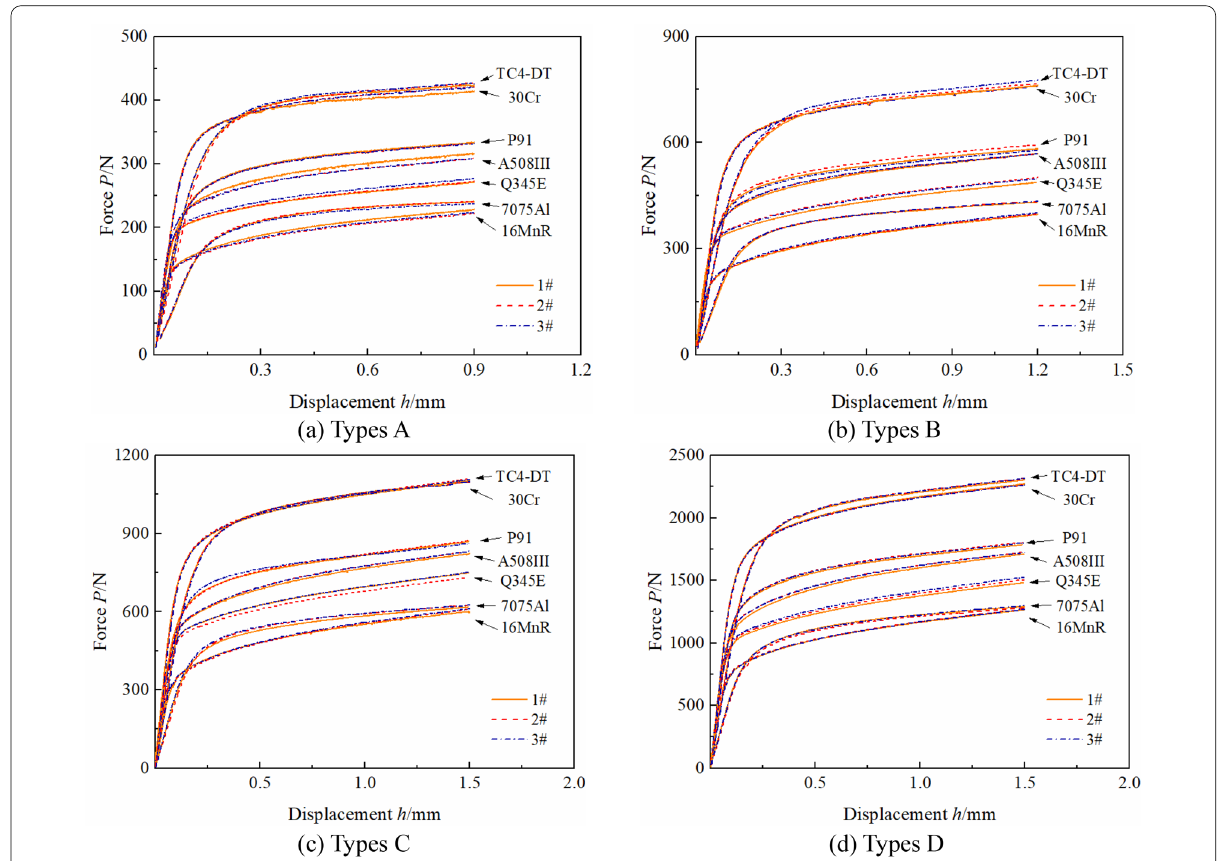
Figure 12 Load–displacement curves of monotonic ring compression tests